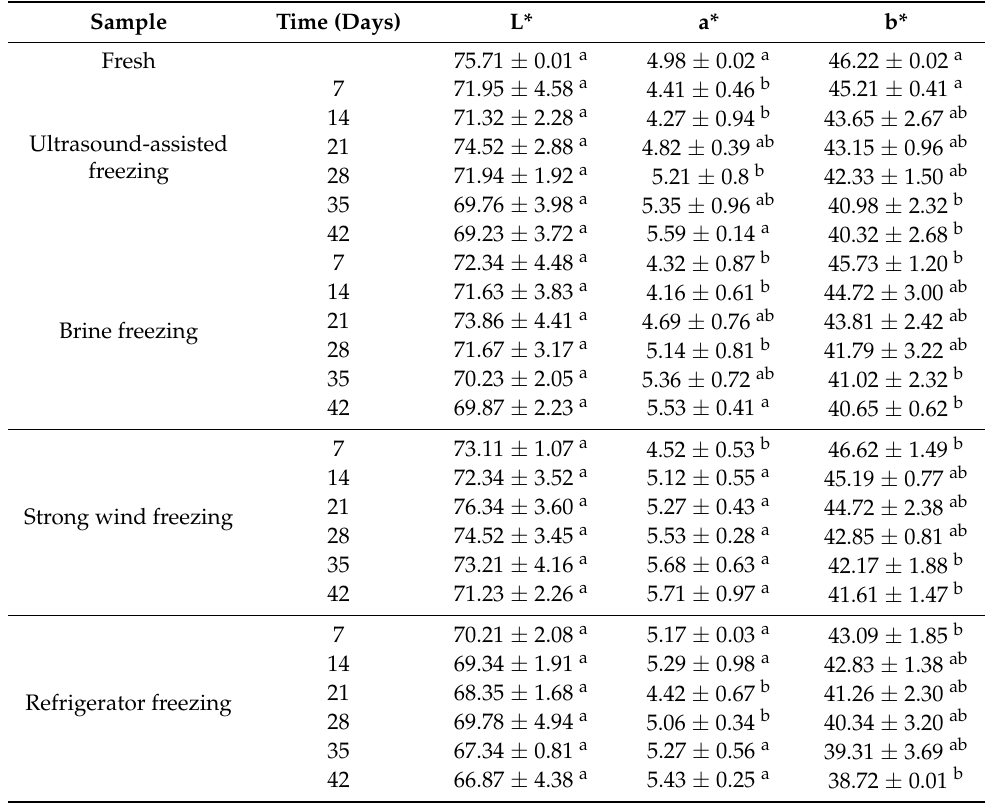
Table 1. Effect of four different freezing methods on L*, a*, b* values of sweet corn. Values with different lowercase letters in the same sampling are significantly different ( p <